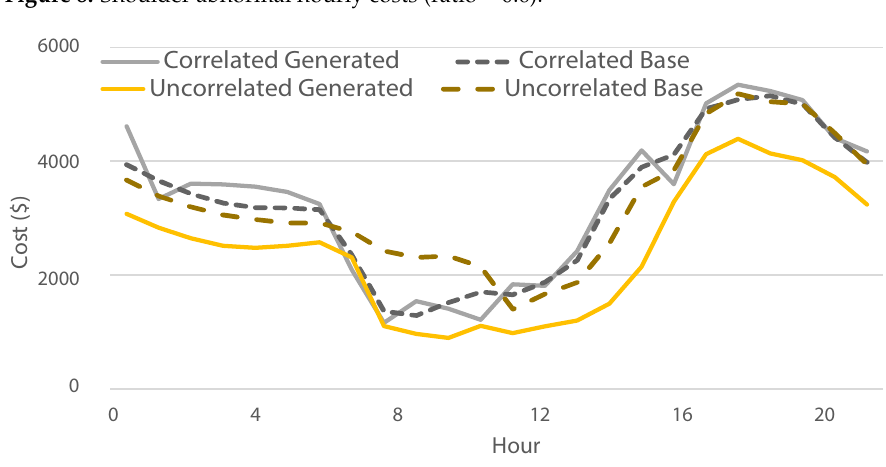
Figure 9. Summer abnormal hourly costs (ratio =